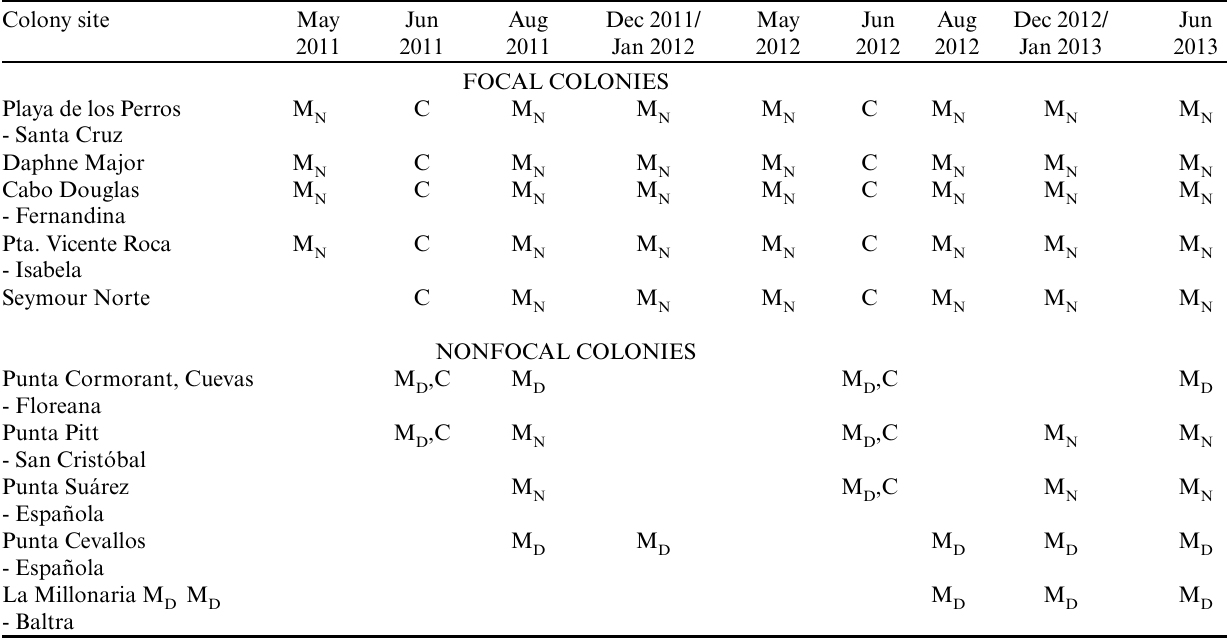
Table 1 . Schedule of visits and activities done on each colony. M night; M : monitoring breeding, presence of banded adults, diet sampling, at day; C: count of adults at day during coastal count across D survey